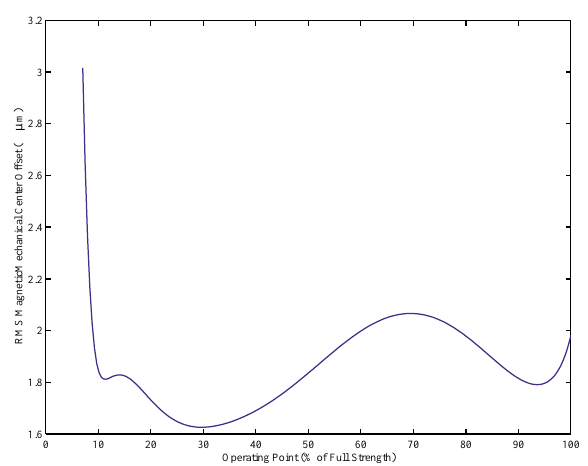
FIG. 3. (Color) rms quadrupole magnetic-mechanical center offset vs excitation using the FFTB magnet model.